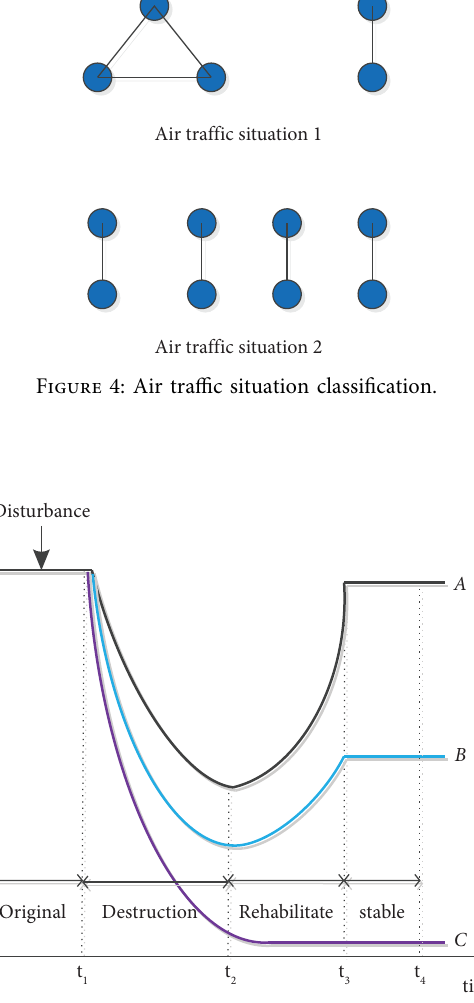
Figure 5: System performance changes before and after